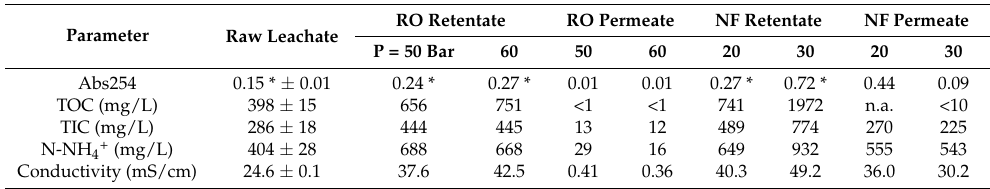
Table 7. Measured parameters in feed, retentate and permeate samples from scheme 2—RO (50 bar) → NF (30 bar) and RO (60 bar) → NF (20